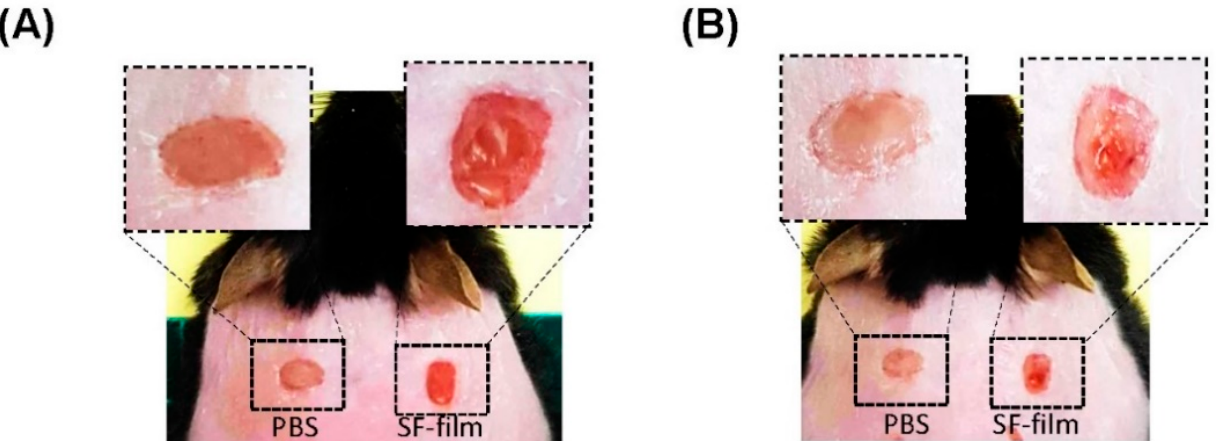
Figure 8. Characterization of diabetic wound tissue formation by SF-film treatment. Images of 8 mm full-thickness dorsal wounds in db/db mice five days ( A ) and eight days ( B ) post-wounding. The wounds were treated with PBS (left) and PBS/SF-film (right).